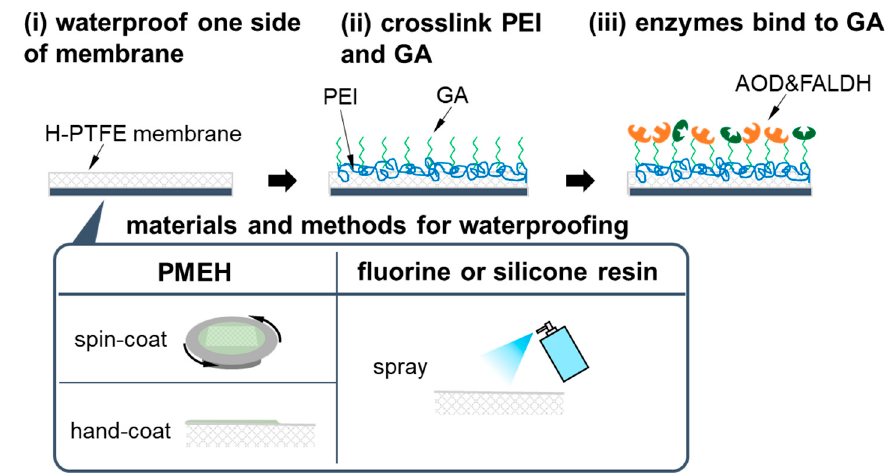
Figure 2. Preparation processes of the AOD-FALDH membrane.